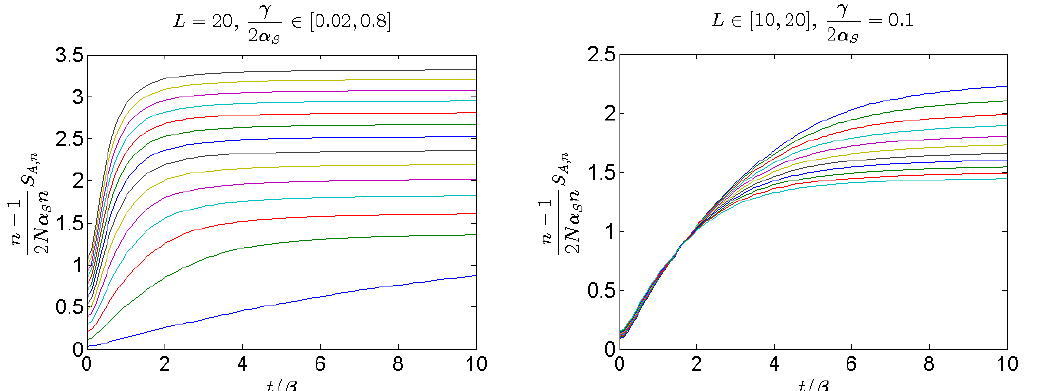
Figure 6 . Numerical results of the entropy as a function of time and parameters L; (cid:13) . The entropy is measured in unit 2 N(cid:11) S n (the coe(cid:14)cient of the area term in the expression of entropy (5.1)). Left n (cid:0) 1 panel shows the entropy growth for (cid:12)xed L = 20 and di(cid:11)erent (cid:13) (higher (cid:13) corresponds to curves with higher entropy). Right panel shows the entropy growth for di(cid:11)erent L 2 [10 ; 20] for (cid:12)xed (cid:13) = 0 : 2 (cid:11) S